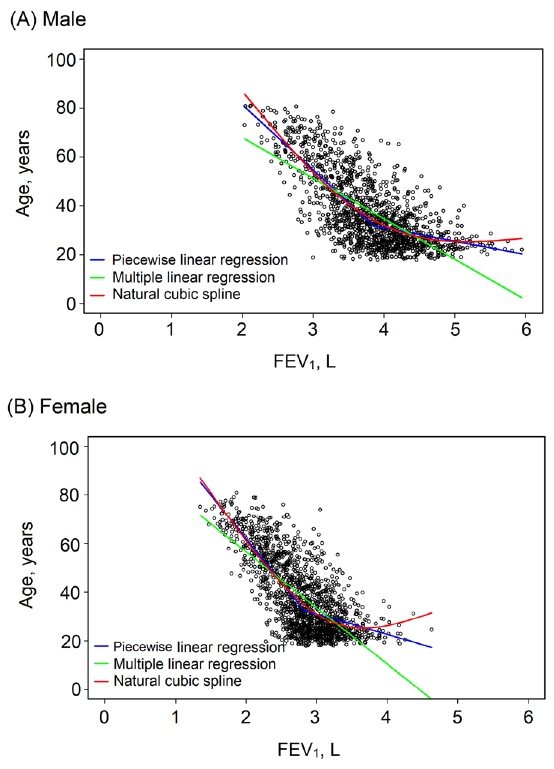
Fig. 2 Fitting curves of the lung age estimation equations developed by different methods. Panel A , fi tting curves of lung age estimation equatitons in males; Panel B , fi tting curves of lung age estimation equatitons in females.